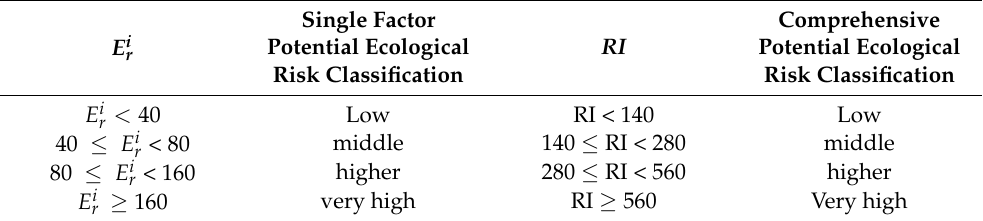
very high RI ≥ 560 Very